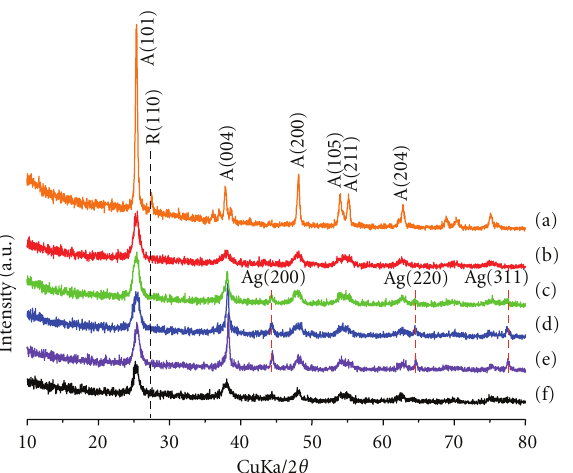
Figure 3: The XRD patterns of six photocatalysts as-synthesized. (a) TiO 2 , (b) Cu(0.1)-Ti(0.9)O 2 , (c) Cu(0.07)-Ag(0.03)Ti(0.9)O 2 , (d) Cu(0.05)-Ag(0.05)Ti(0.9)O 2 , (e) Cu(0.03)-Ag(0.07)Ti(0.9)O 2 , and (f) Ag(0.1)-Ti(0.9)O 2